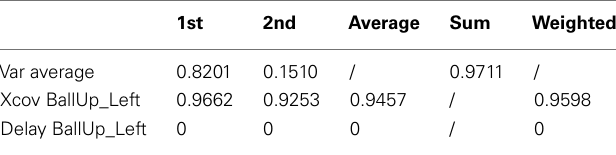
Table 6 | Reaching a target with the left hand (2 subjects). Table 7 | Reaching a target with the left and the right hand (2